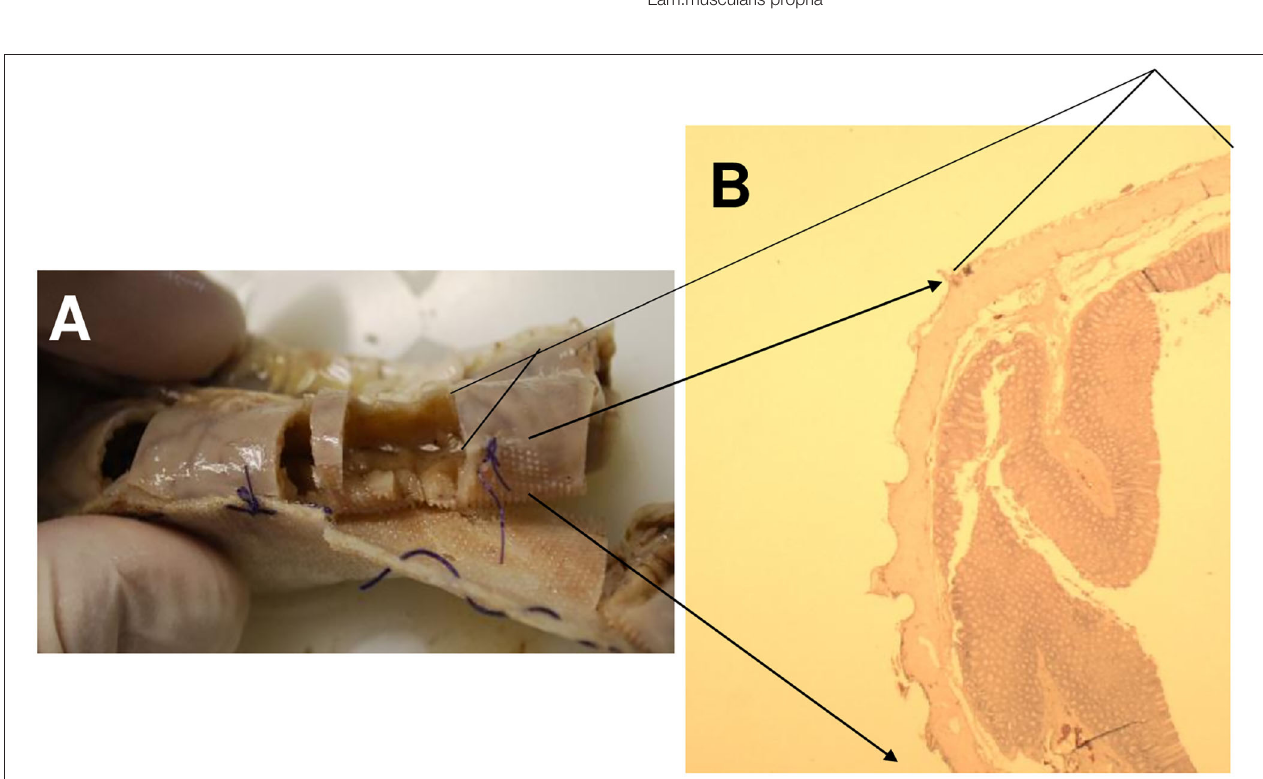
FIGURE 5 | Animal 1, − 80 mmHg. (A) Small intestine resection. Section after removal of the patch with a paving stone-shaped pattern (delimited by arrows). Non-patch area with smooth surface marked by bars. (B) Small intestine wall from the “patch” section near the anastomosis. Superficially with extensions (arrow) consisting of serosa, subserosa, and L. muscularis propria. This is with a paving stone-shaped surface (arrow). Underlying layers without pathological changes. Section marked with a bar from the non-patch area with a smooth surface (bar, corresponding to the bar in the macro illustration opposite).